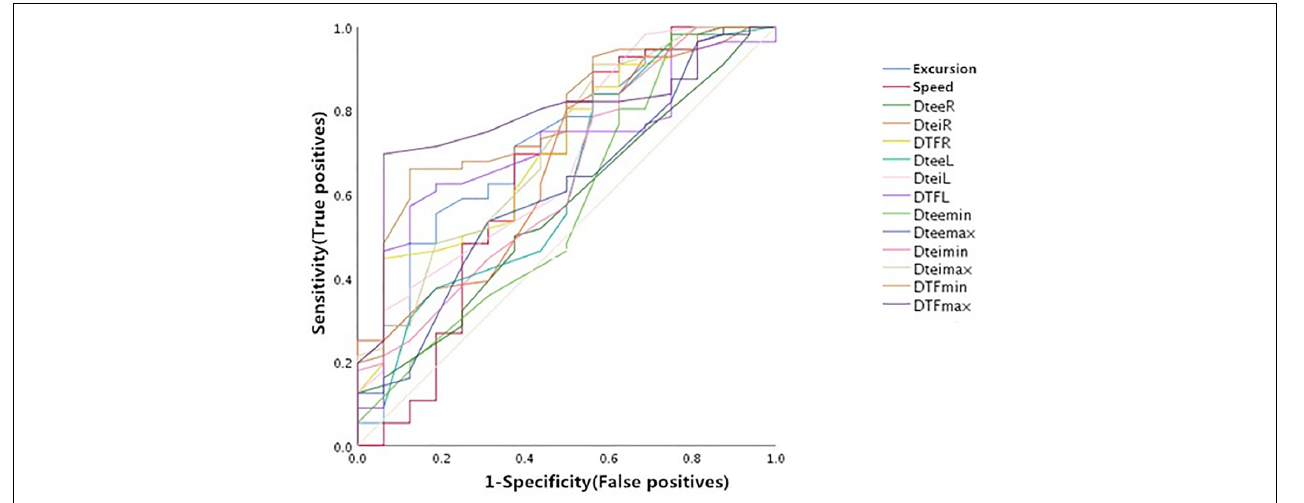
FIGURE 4 | Receiver operator characteristic (ROCs) of the diaphragm ultrasound indices predicting weaning outcome before weaning. Dtee R , right diaphragm thickness at the end of expiration; Dtei R , right diaphragm thickness at the end of inspiration; DTF R , right diaphragm thickening fraction; Dtee L , left diaphragm thickness at the end of expiration; Dtei L , left diaphragm thickness at the end of inspiration; DTF L , left diaphragm thickening fraction; Dtee MIN , minimum diaphragm thickness at the end of expiration; Dtee MAX , maximum diaphragm thickness at the end of expiration; Dtei MIN , minimum diaphragm thickness at the end of inspiration; Dtei MAX , maximum diaphragm thickness at the end of inspiration; DTF MIN , minimum diaphragm thickening fraction; DTF MAX , maximum diaphragm thickening fraction. TABLE 3 | Prediction efficiency of each diaphragm ultrasound index to the weaning outcome. Parameters AUC (95% CI) p -Value Threshold Sensitivity (%) Specificity (%) Positive predictive Excursion (mm)